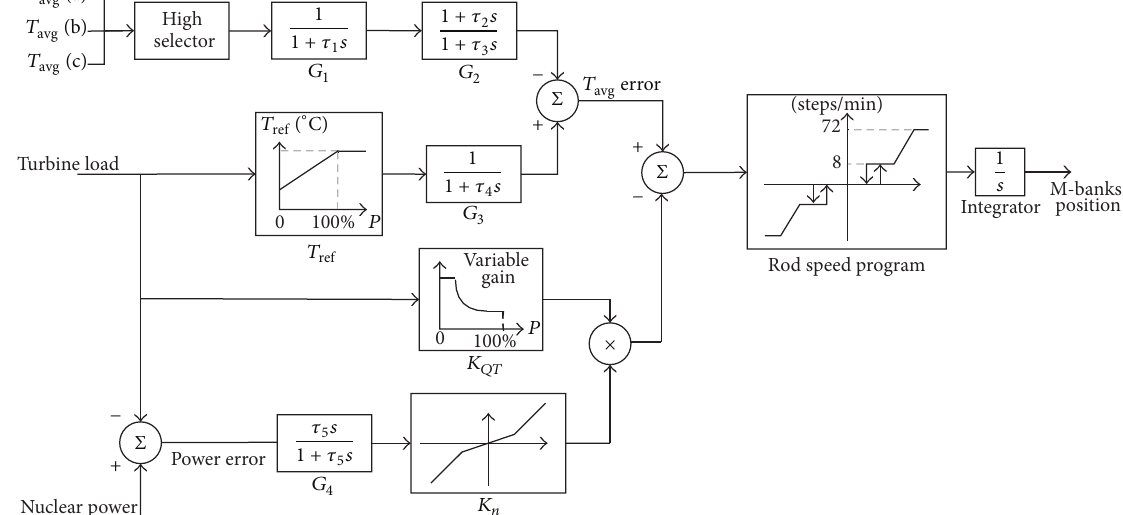
Figure 4: Block diagram of the power control system of MSHIM in